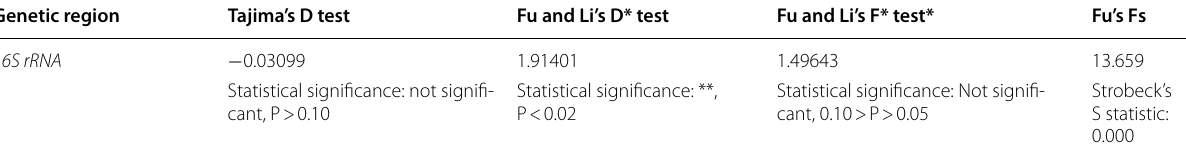
Table 4 Neutrality test results based on the 16S rRNA region of the bacterial Vibrio population Genetic